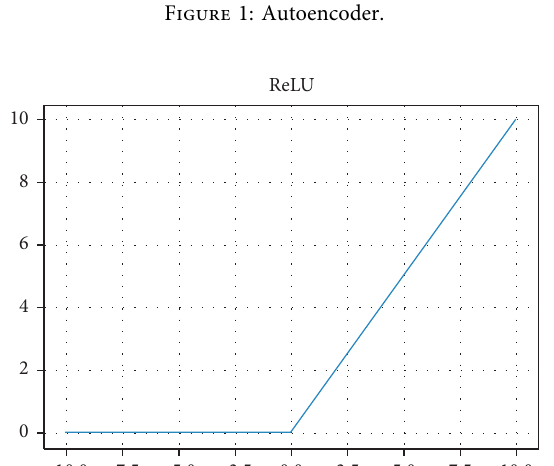
Figure 1: Autoencoder.